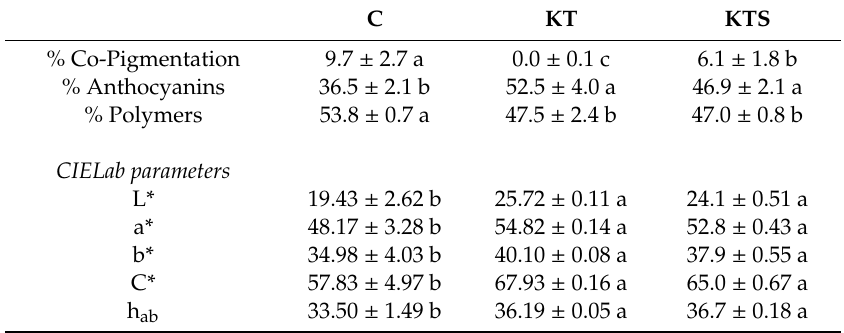
Table 3. Percentage contribution to the color and CIELab parameters of wines after 7 days of treatment with chitosan. In the same row, di ff erent letters indicate significant di ff erences according to Tukey’s